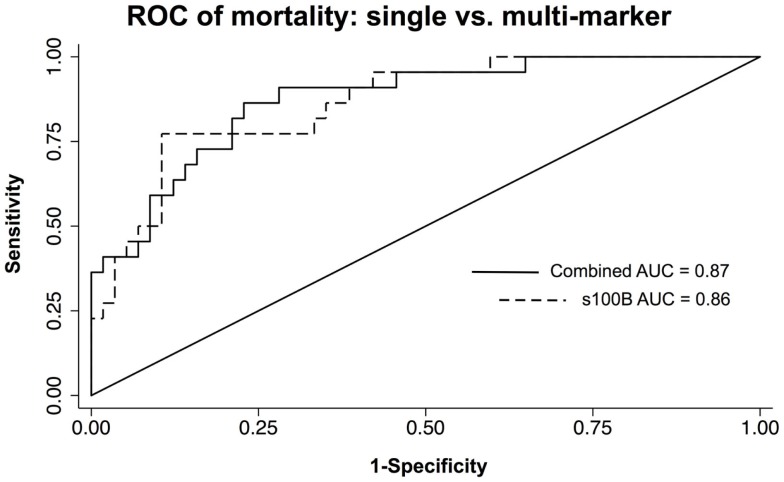
ROC curves of neuroinjury markers used to discriminate death from survival in TBI patients. A combined AUC consisting of s100B, GFAP, and MCP-1 was not statistically better than s100B alone in discriminating death from survival by chi-squared.